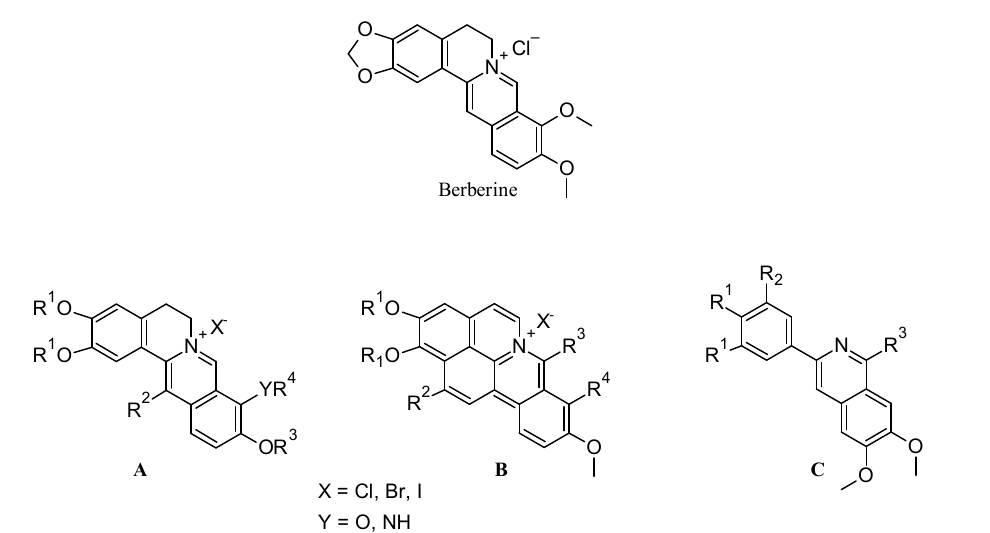
Figure 1. General structures of most of the antimicrobial berberine derivatives reported in the literature ( A – C ).